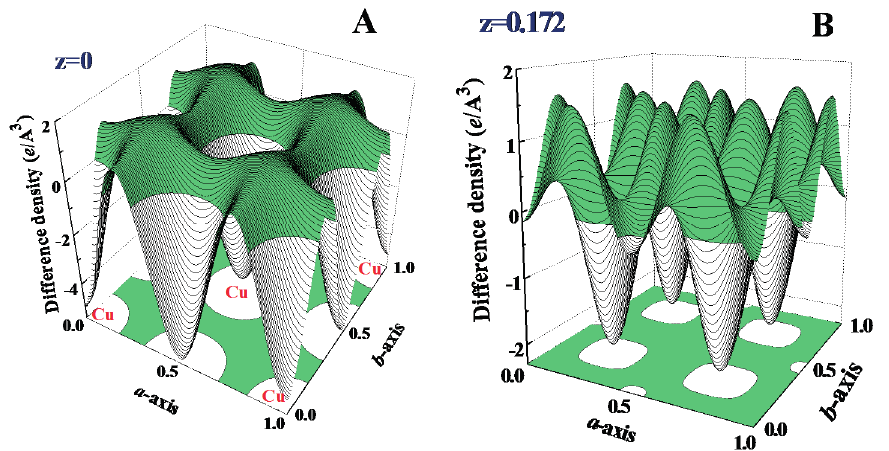
Figure 5. Difference of the electronic charge density between the 6.6 nm Cu assembly and 2 mm Cu ingot on the ( A ) z = 0 and ( B ) z = 0.172 planes. The color-filled regions indicate the positions having a positive difference charge density, where the charge density of the nanoparticles is higher than that of the 2 mm ingot. The projection of the electronic charge density onto the lattice plane is shown at